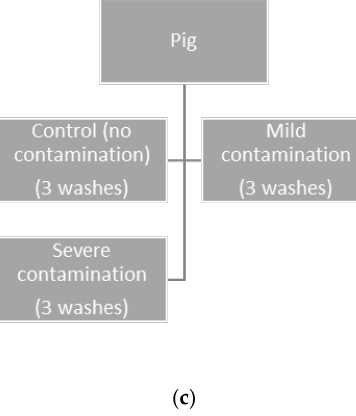
Figure 1. Experimental design of studies performed. Study 1: the effect of wash solvent on hair and solvent cortisol and DHEA concentrations ( a ); Study 2: the effect of contamination level and wash number on hair and methanol solvent cor- tisol and DHEA concentrations and the solvent-hair ratio ( b , c